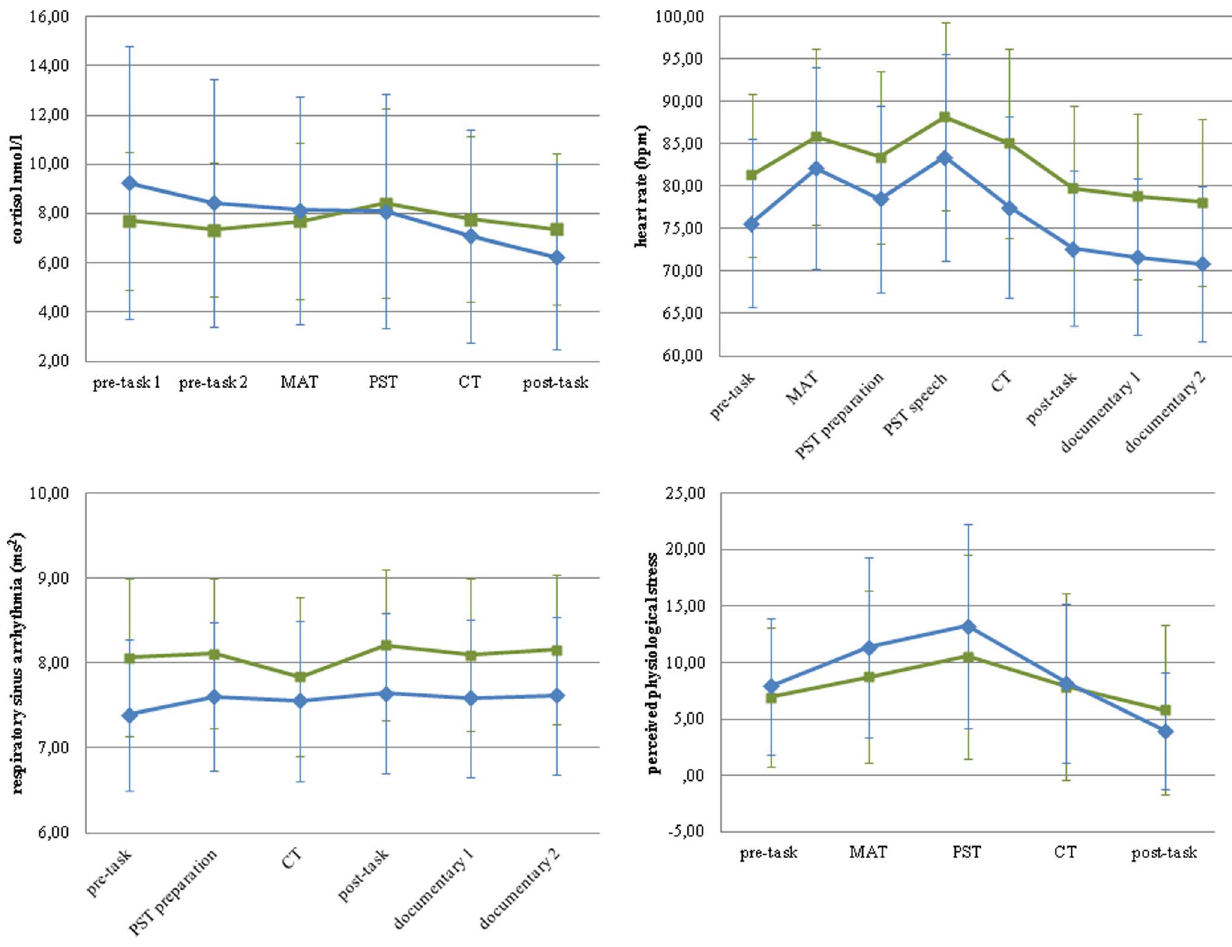
Figure 2. Raw data for each of the stress response variables across the psychosocial stress procedure in children and adolescents. Notes. MAT=mental arithmetic task; PST=public speaking task; CT=computer task; bpm=beats per minute.